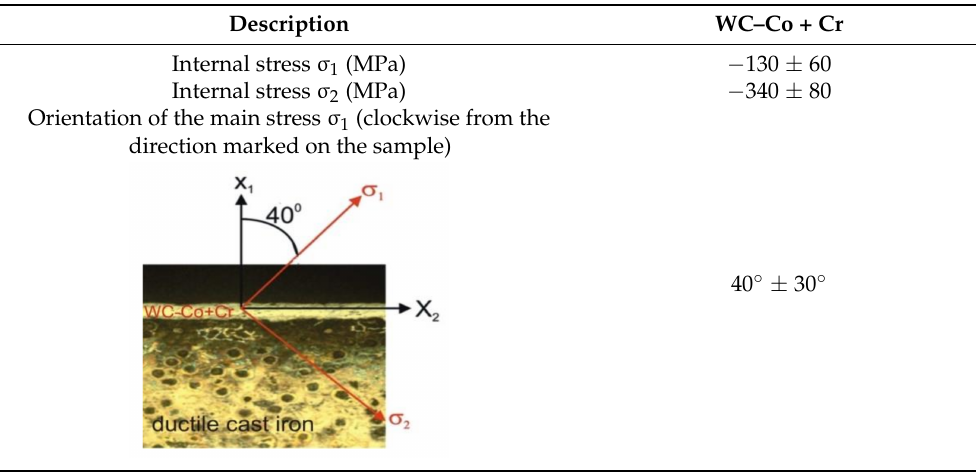
Table 4. Results of an analysis of residual stresses in WC – Co + Cr coating.